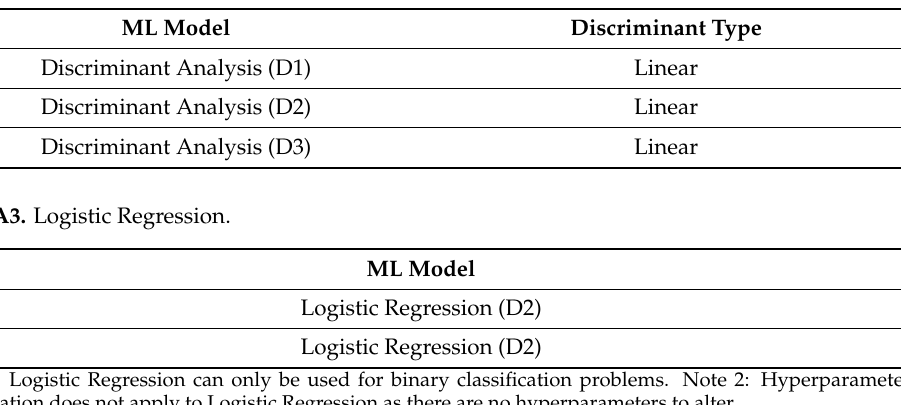
Table A2. Discriminant Analysis: optimal hyperparameters for each dataset.